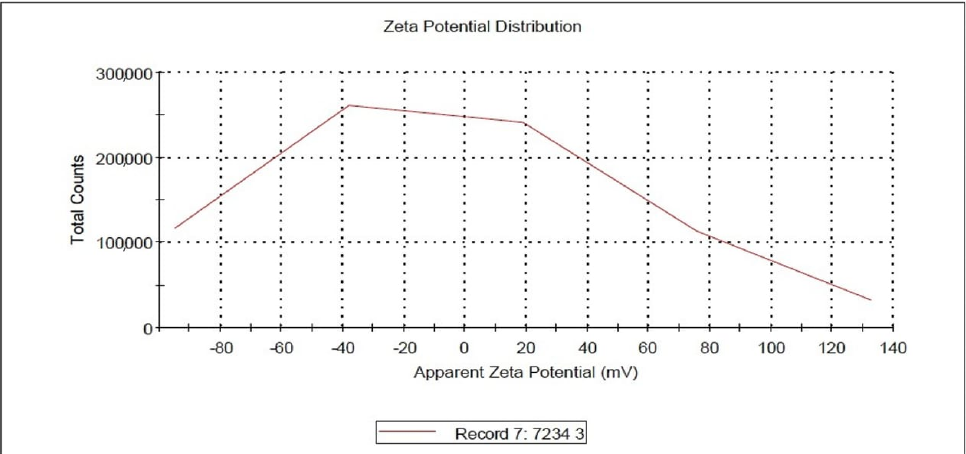
Figure 4. Zeta potential distribution of the experimental nano-zeolite.